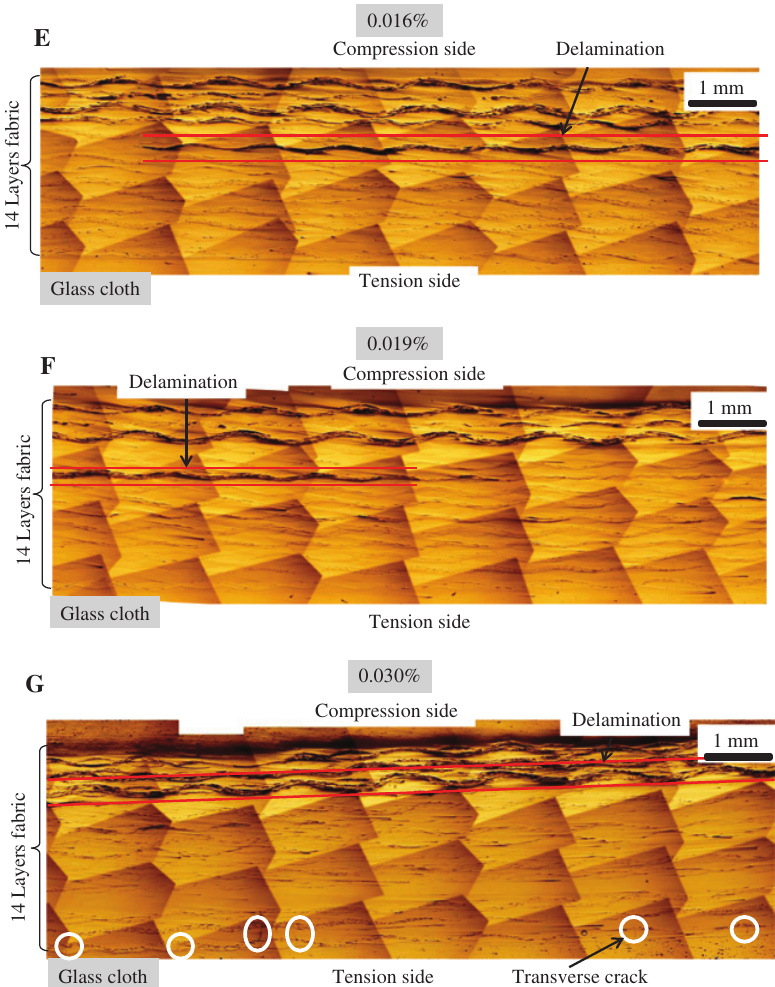
Figure 8 Cross-sectional photographs of specimens with various strains during the three-point bending test: (A–D) glass roving and (E–G) glass